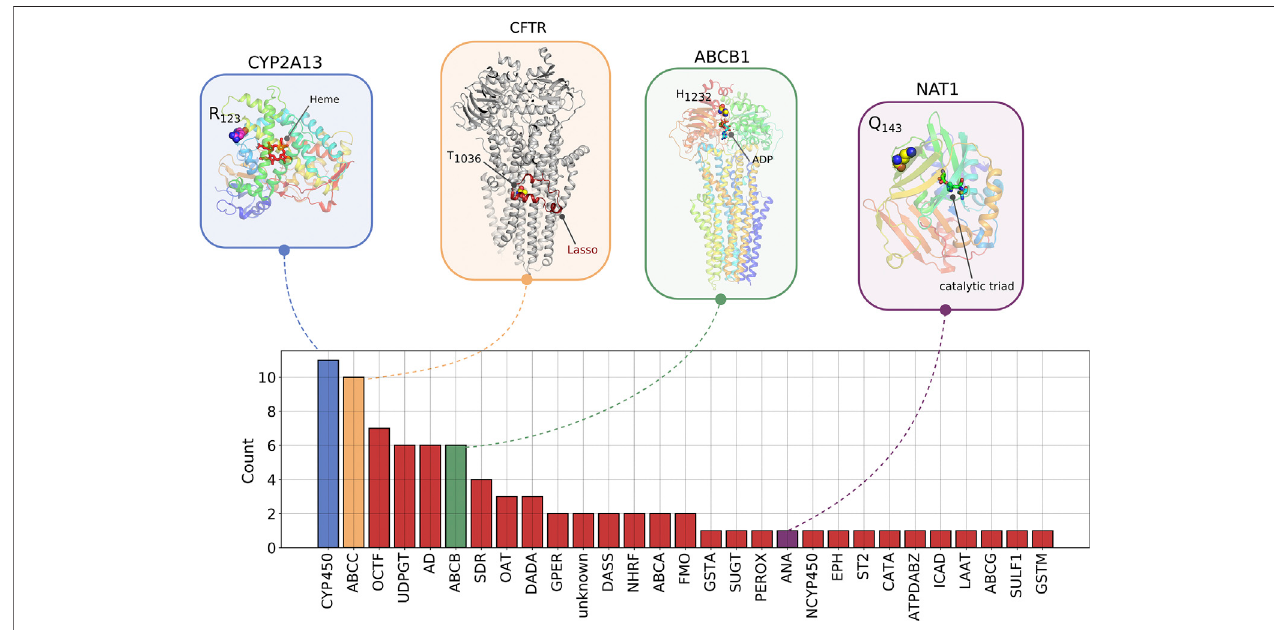
FIGURE9| Characterization of novel variant distribution across the ADME genes in HAAD. Variants are indexed by descending MAF for core genes (A) and extended genes (B) for the total population of HAAD samples. Circular plots for core (C) and extended genes (D) show the position of the unique variants per each cluster across the index axes represented by points. The index represents the MAF of the variant in the total HAAD dataset. A link is established if two clusters share the same variant. The FW cluster has fewer variants in common with other clusters in this fi gure due to low sample number used to generate this fi